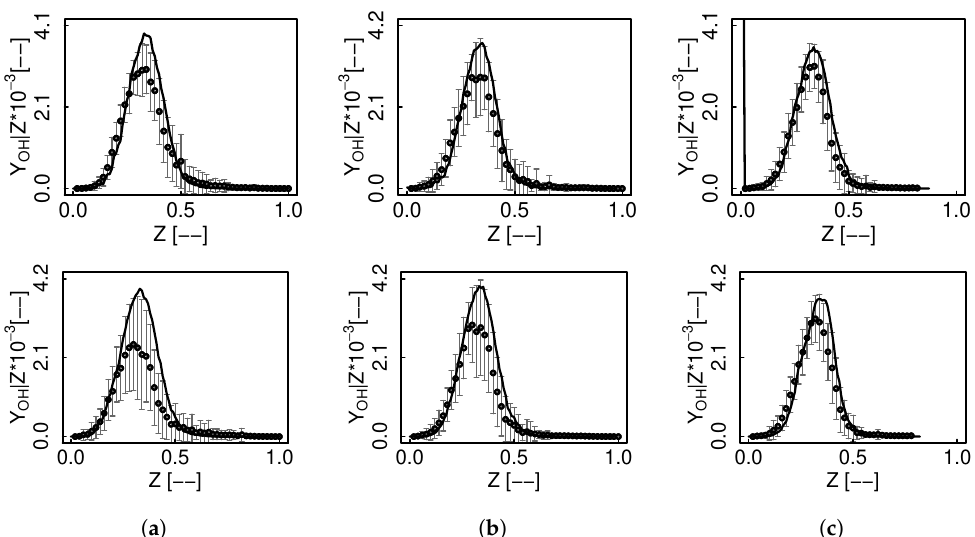
Figure 18. Non-premixed FTACLES conditional mean mass fraction of OH for flame D ( top ) and E ( bottom ). Solid line represents the simulation, circles the experimental data and error bars RMS. ( a ) x / d = 7.5; ( b ) x / d = 15; ( c ) x / d =